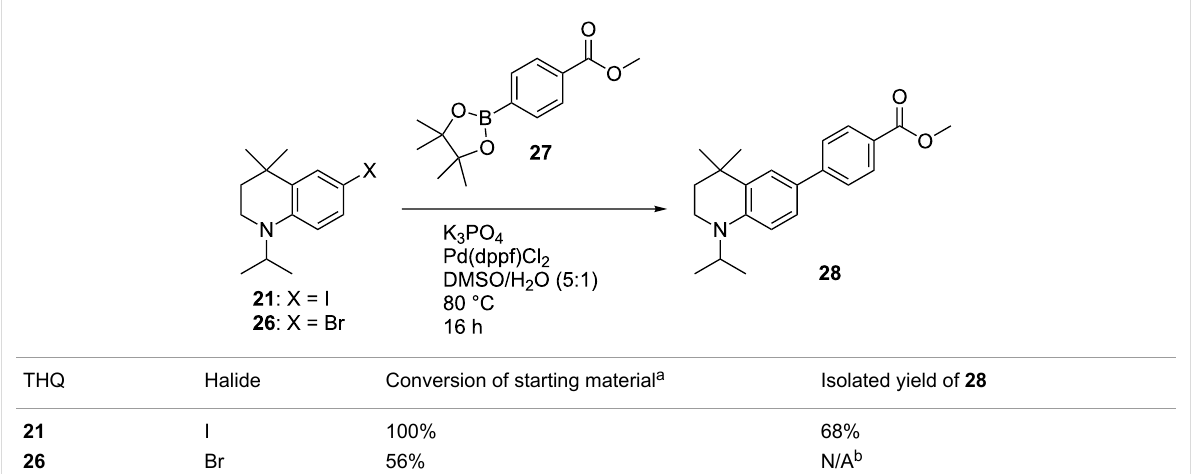
Table 3: Comparing the reactivity of 6-iodo-THQ 21 and 6-bromo-THQ 26 in a typical Suzuki reaction with boronic ester 27 to give biaryl 28 .